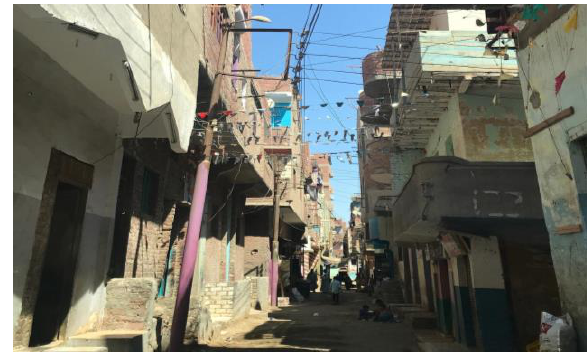
Figure 15. One of the streets of Lahun village,